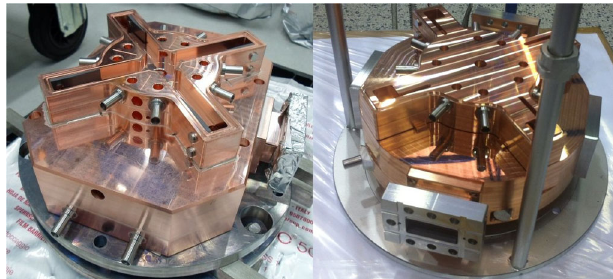
FIG. 6. Brazed input coupler (left) and brazed output coupler (right). 1